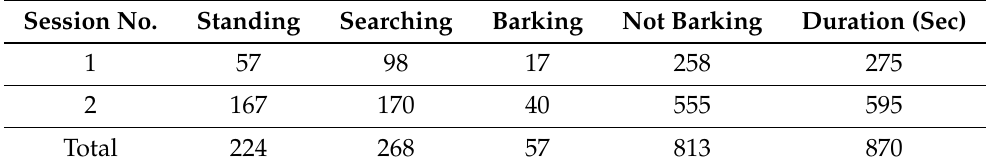
Table 9. Number of samples for two SaR evaluation scenarios.